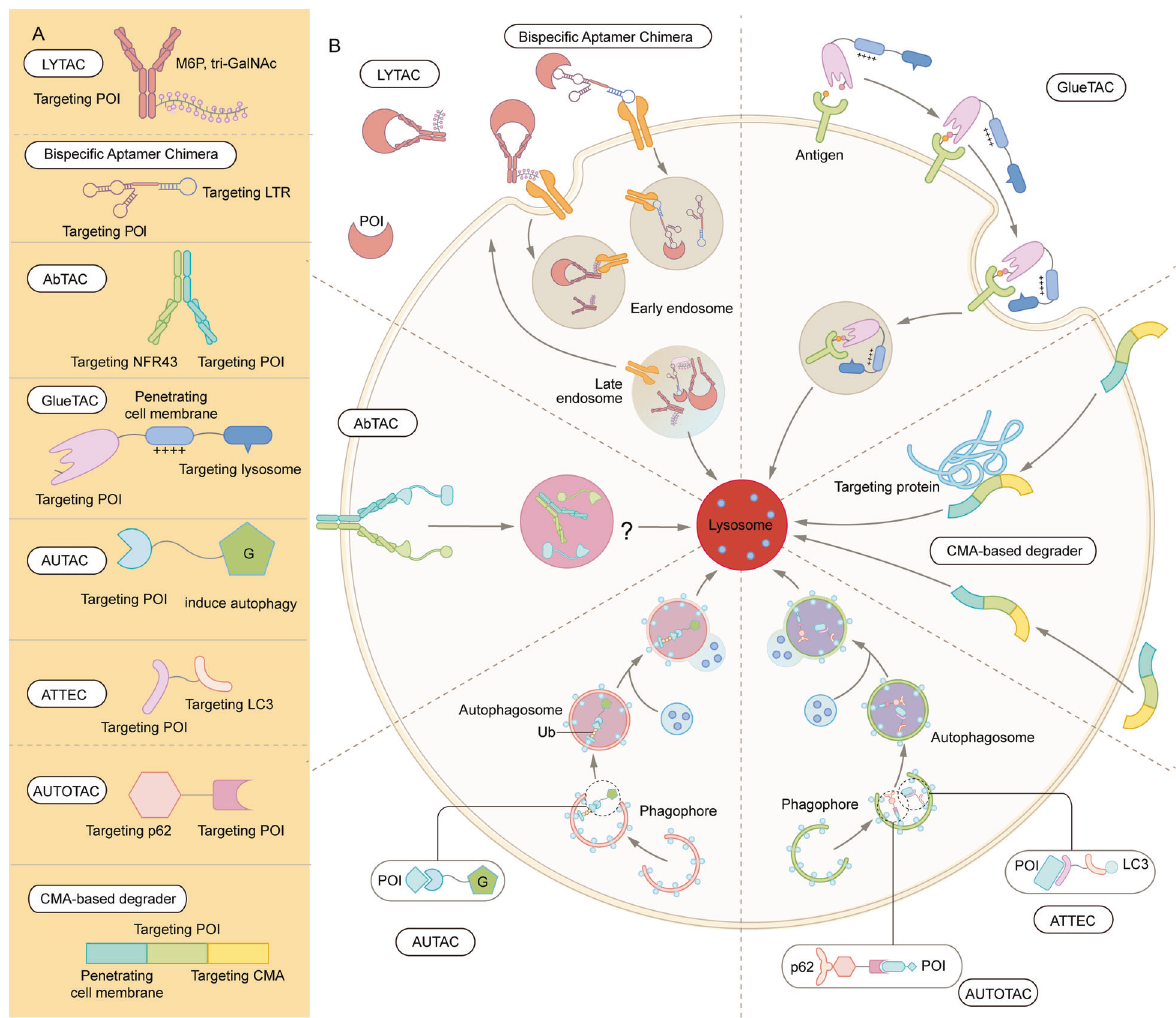
Fig. 6 Summary of lysosome-dependent protein degradation strategies. A Schematic representation of LYTAC and other degradation technologies via the lysosomal pathway. B LYTAC molecules and Bispeci fi c Aptamer Chimeras degrade membrane proteins and extracellular molecules by engaging a POI and a lysosome-targeting receptor (LTR). AbTAC utilizes a membrane E3 ligases, RNF43, for the degradation of membrane proteins, via a lysosome-dependent manner. GlueTAC utilizes a lysosome-sorting sequence (LSS) to promote the lysosomal degradation. AUTAC, ATTEC and AUTOTAC promote the formation of POI-speci fi c autophagosomes, and subsequently the degradation of the POI via lysosomes. CMA-based degrader harness chaperone-mediated autophagy, rather than macroautophagy, for protein